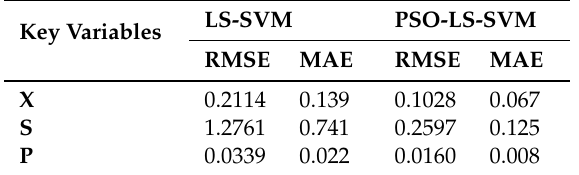
Table 1. The performance difference between PSO-LS-SVM and LS-SVM.